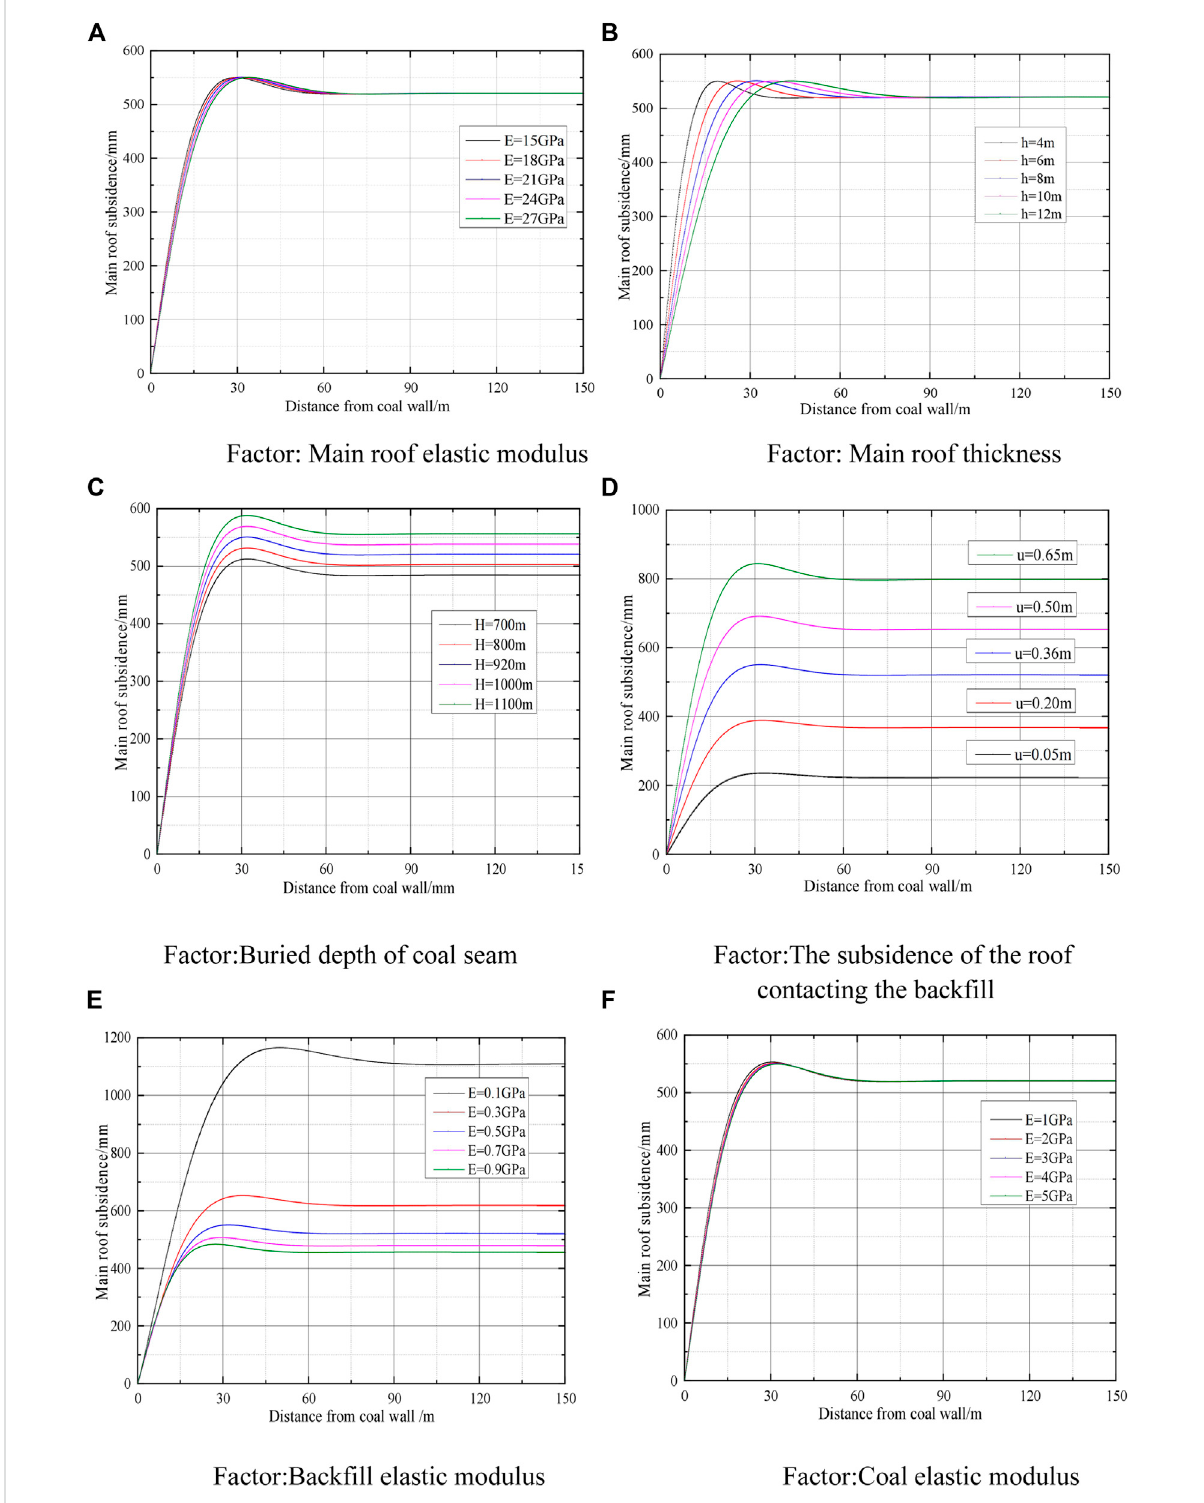
FIGURE 4 Schematicdiagramofthein fl uenceofvariousfactors onthemainroofsubsidence(upperslicingmining). (A) Factor:mainroofelasticmodulus. (B) Factor: main roof thickness. (C) Factor: buried depth of the coal seam. (D) Factor: the subsidence of the roof contacting the back fi ll. (E) Factor: back fi ll elastic modulus. (F) Factor: coal elastic